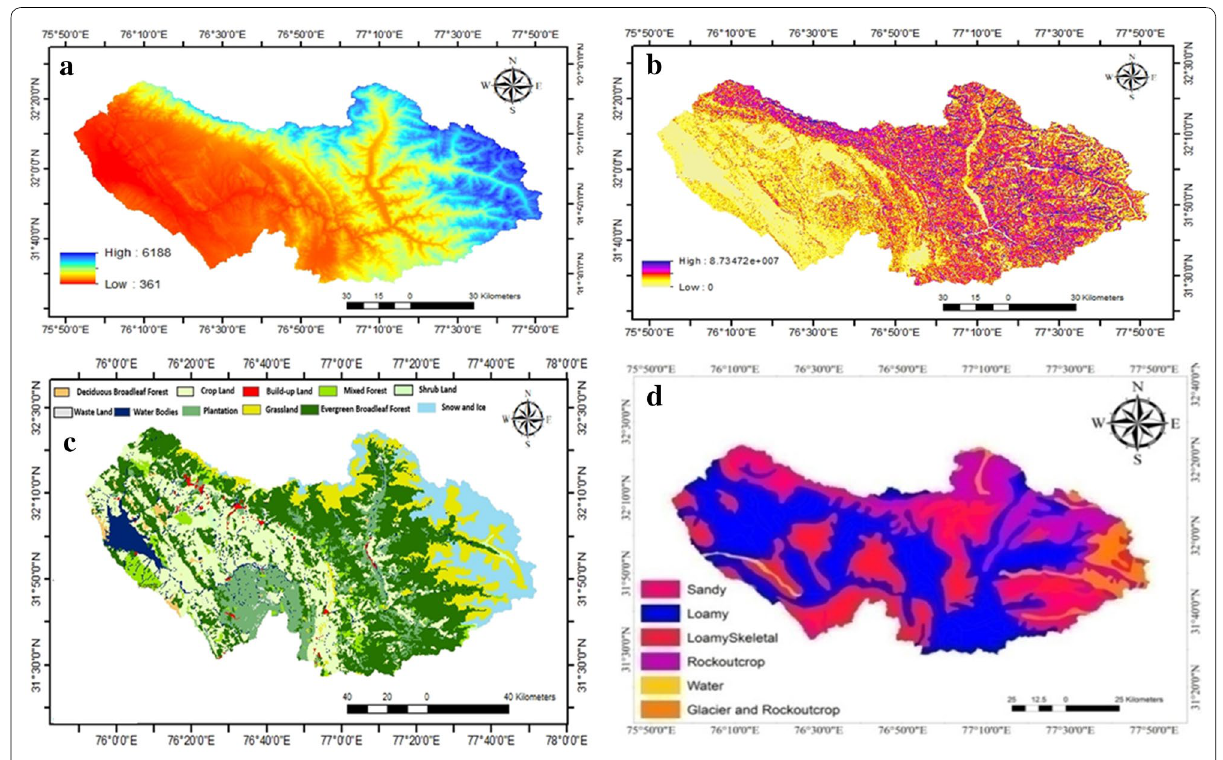
Fig. 4 a DEM map, b Slope map, c LULC map, and d Soil map of Beas